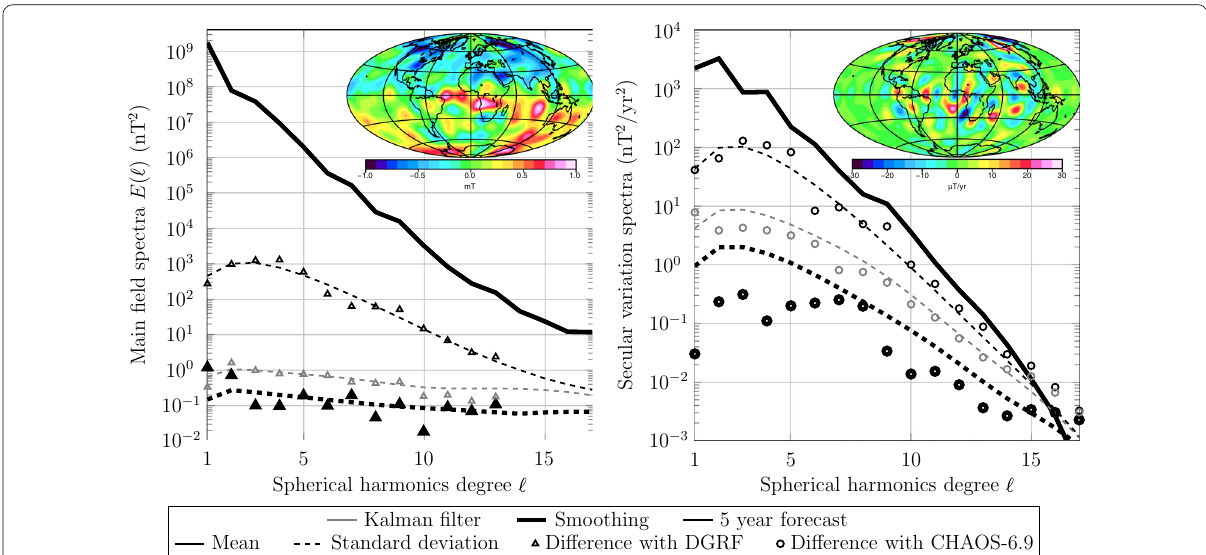
Fig. 3 Energy spectra at the Earth’s surface in 2015.0 associated with the main field (left) and the secular variation (right). Thin gray lines and symbols and thick black lines and symbols, correspond to the solutions of the Kalman filter and the smoothing algorithms, respectively. The thin black lines and symbols are associated with the outcomes of a 2010.0–2015.0 forecast simulation. Continuous and dashed lines are assigned to the energy spectra of, respectively, the different mean solutions and their associated standard deviation. Triangles and circles represent the spectra of the difference between the Kalmag mean models and the DGRF model in 2015.0 for the main field and the CHAOS-6.9 model of Finlay et al. (2016) for the secular variation, respectively. The inserted color maps correspond to the radial component of the core field (left) and the secular variation (right) at the core mantle boundary. They are from the 2015.0 smoothing solution expanded up to SH degree ℓ =